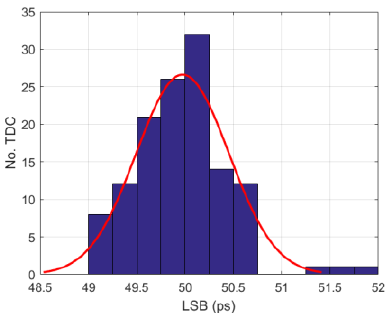
Figure 11. LSB distribution of the 128 TDCs shows a standard deviation of 0.48 ps.